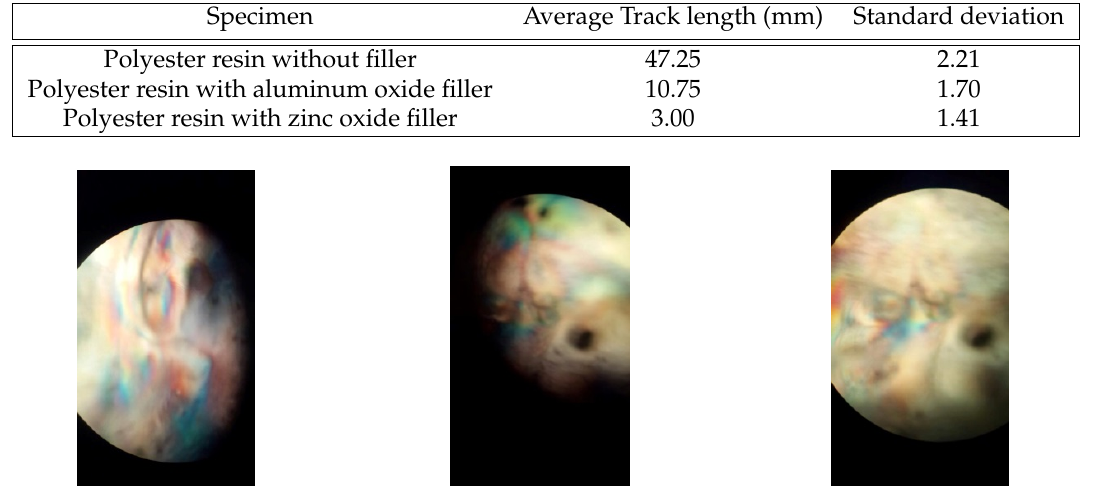
Figure 6. Polyester resin with filler of Aluminum oxide and Zinc